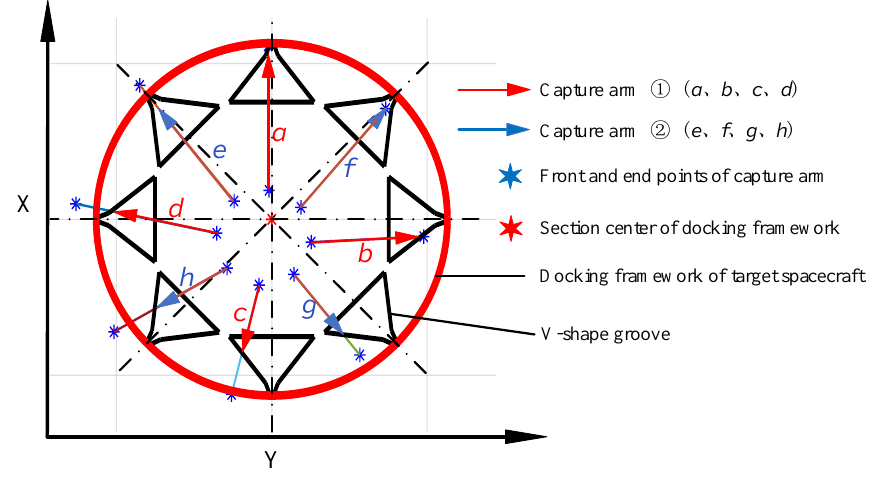
Figure 7. A kind of initial posture working condition docking end surface.